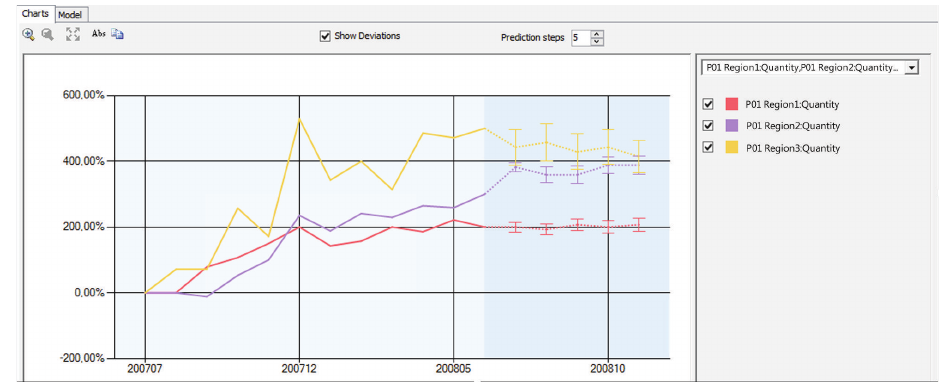
Figure 6: Forecasting data with